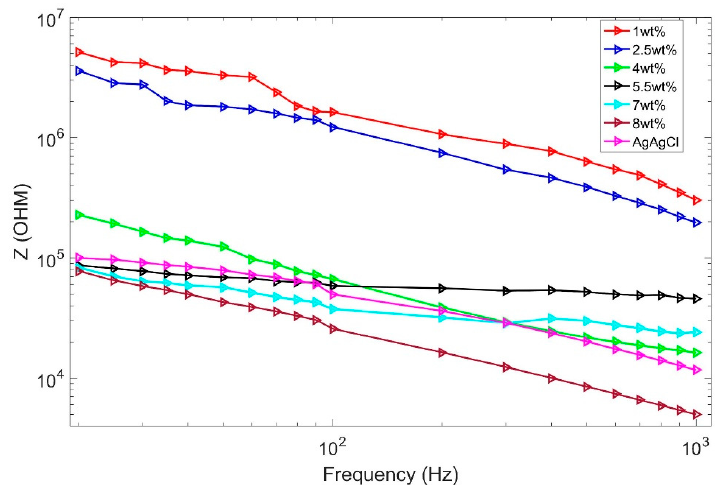
Figure 5. Skin–electrode contact impedance comparison.